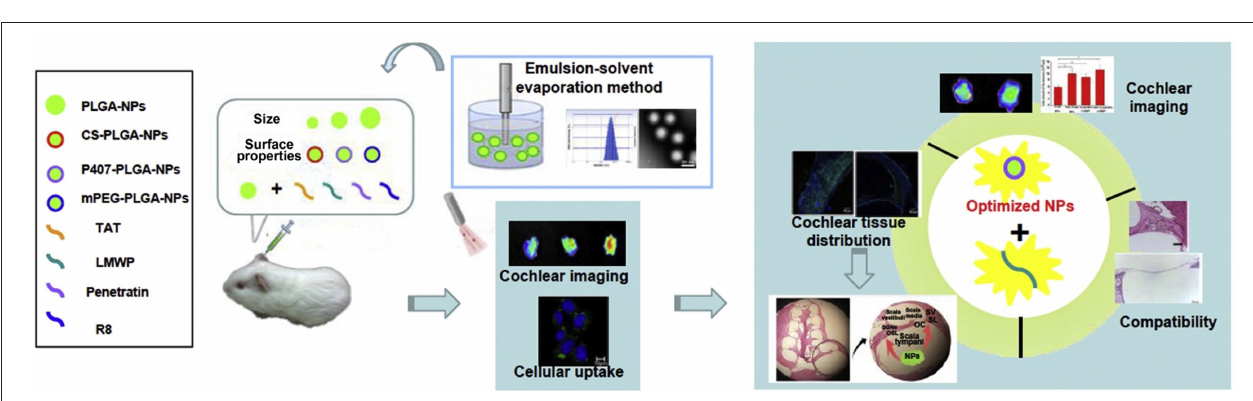
nanoparticles could be prepared by modifying the surface with polyethylene glycol, carbohydrates, and folic